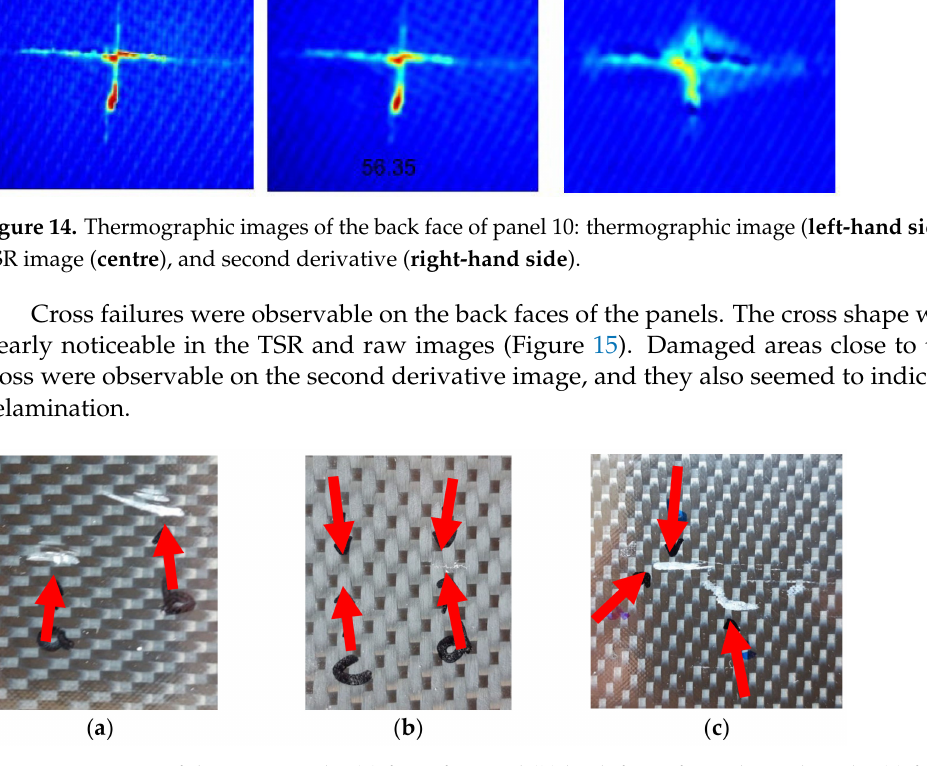
Figure 15. Images of damages on the ( a ) front face and ( b ) back face of panel 1 and on the ( c ) front face of panel 3.